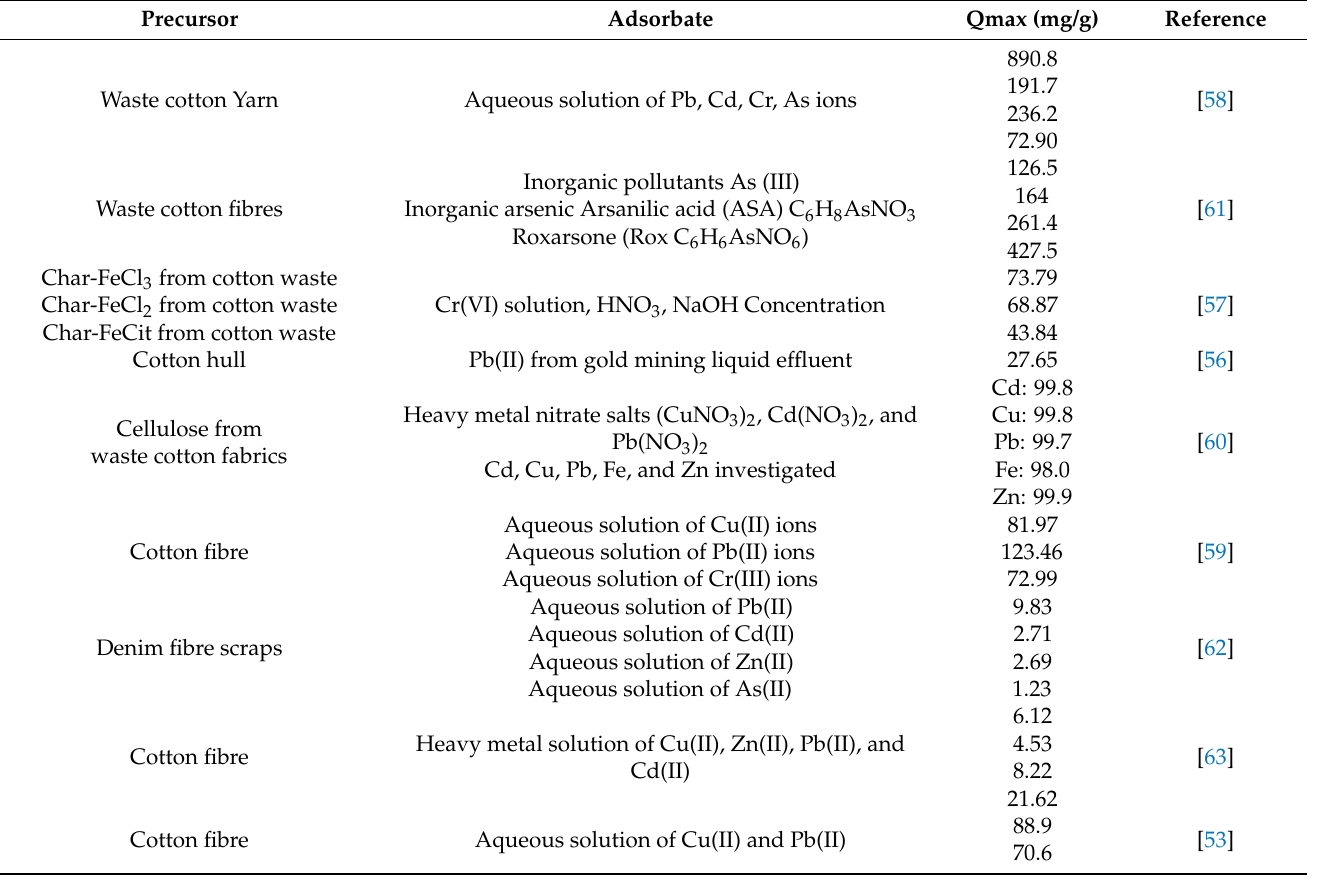
Table 2. Adsorption of heavy metals on textile